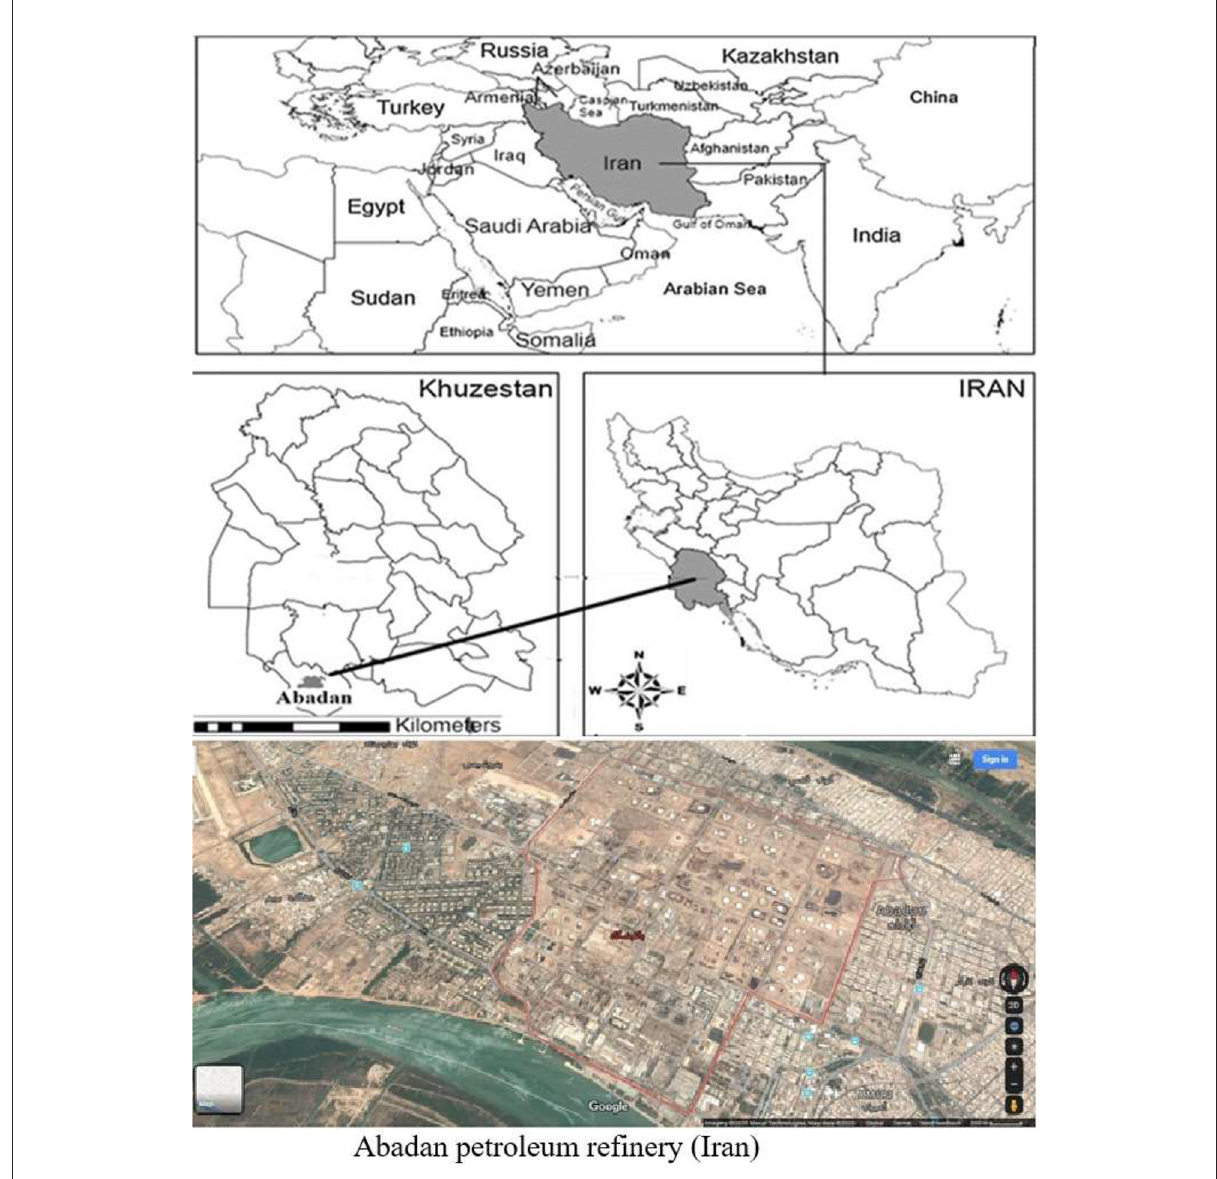
FIGURE1 Location of the study area Abadan Oil Refining Company, in the south west of Iran.